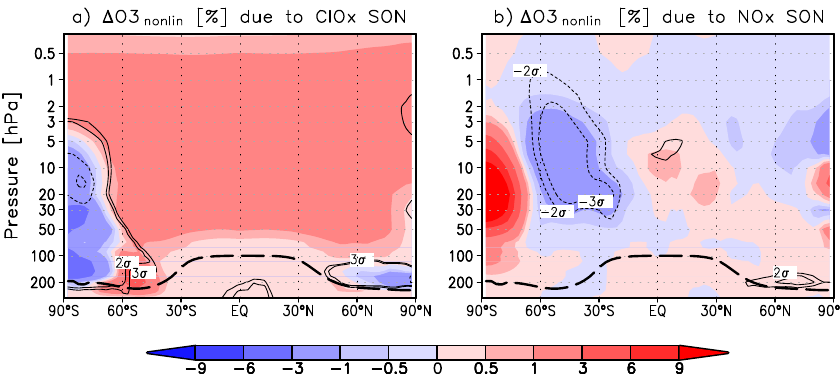
Figure 7. Latitude-height section of the SON mean nonlinear O 3 changes due to the ClO x (a) and the NO x cycle (b) derived from